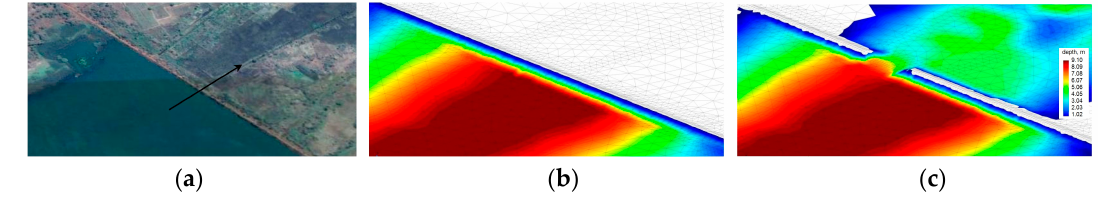
Figure 5. Position of the breach within the dam ( a ); initial conditions ( b ); and developed breach ( c ).